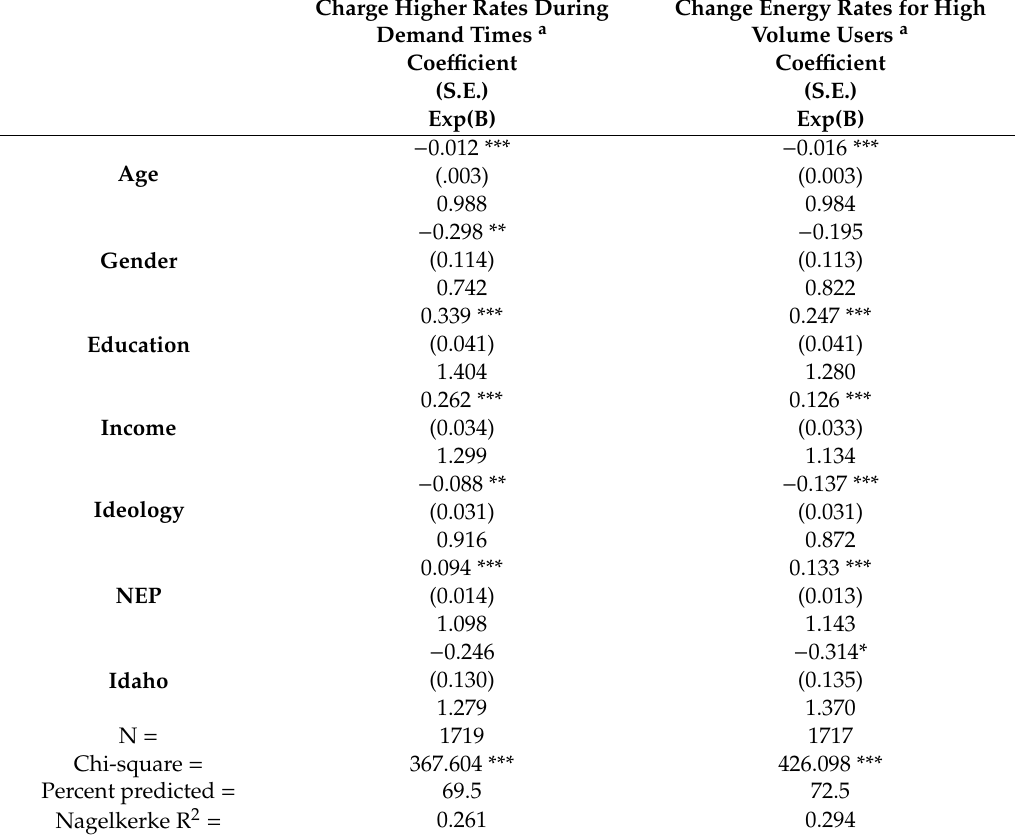
Table 7. Logistic Regression Estimates for Energy Price Discrimination